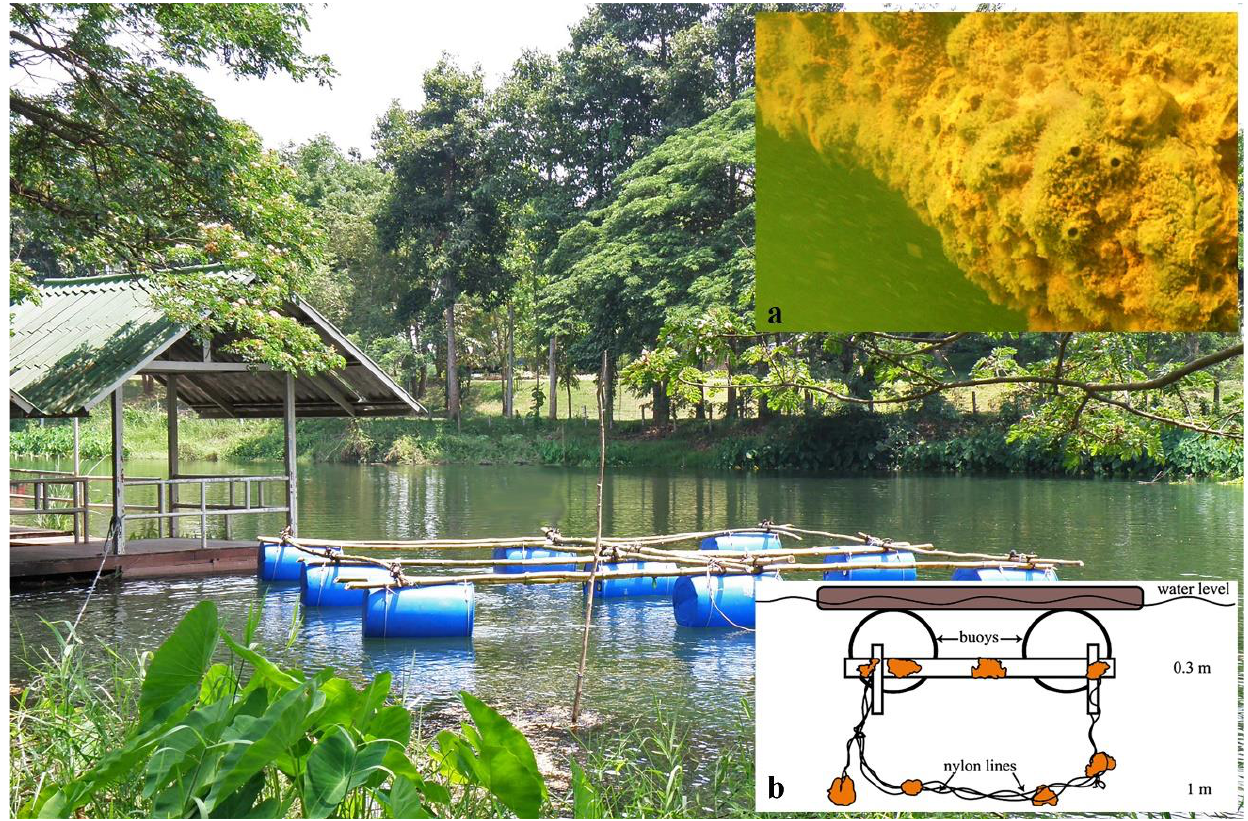
Figure 2. View of the study site. ( a ) Corvospongilla siamensis on artificial substrata. ( b ) Schematic diagram of a raft, submerged structures, and nylon lines colonized by sponges (orange) at 0.3 – 1 m water depth in the study site.